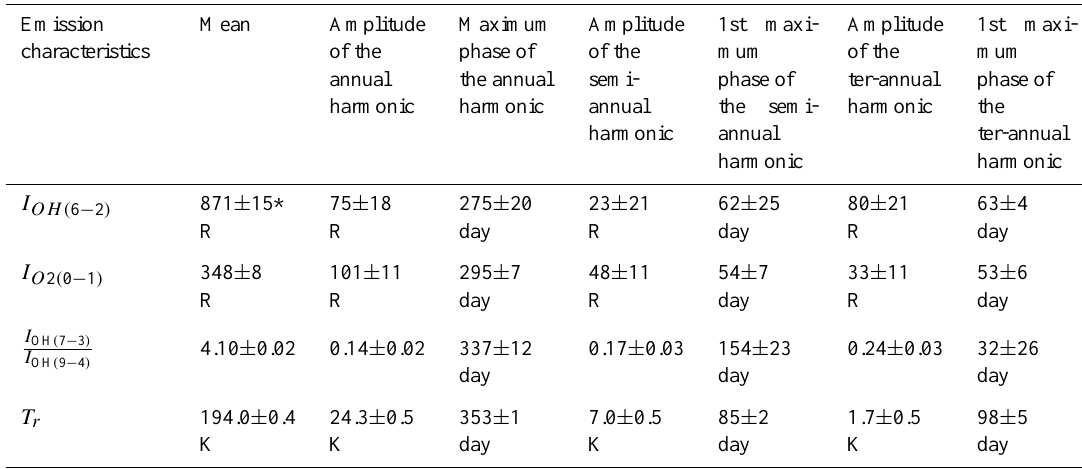
Table 1. Characteristics of seasonal variation harmonics.